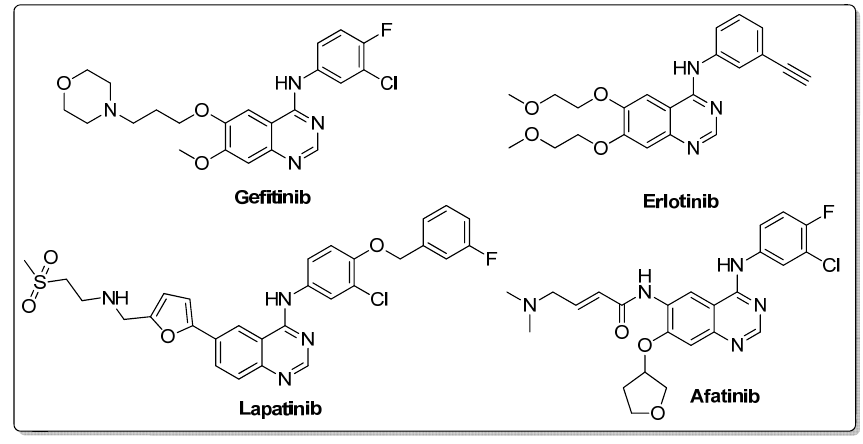
Figure 42. Quinazoline clinical drugs.